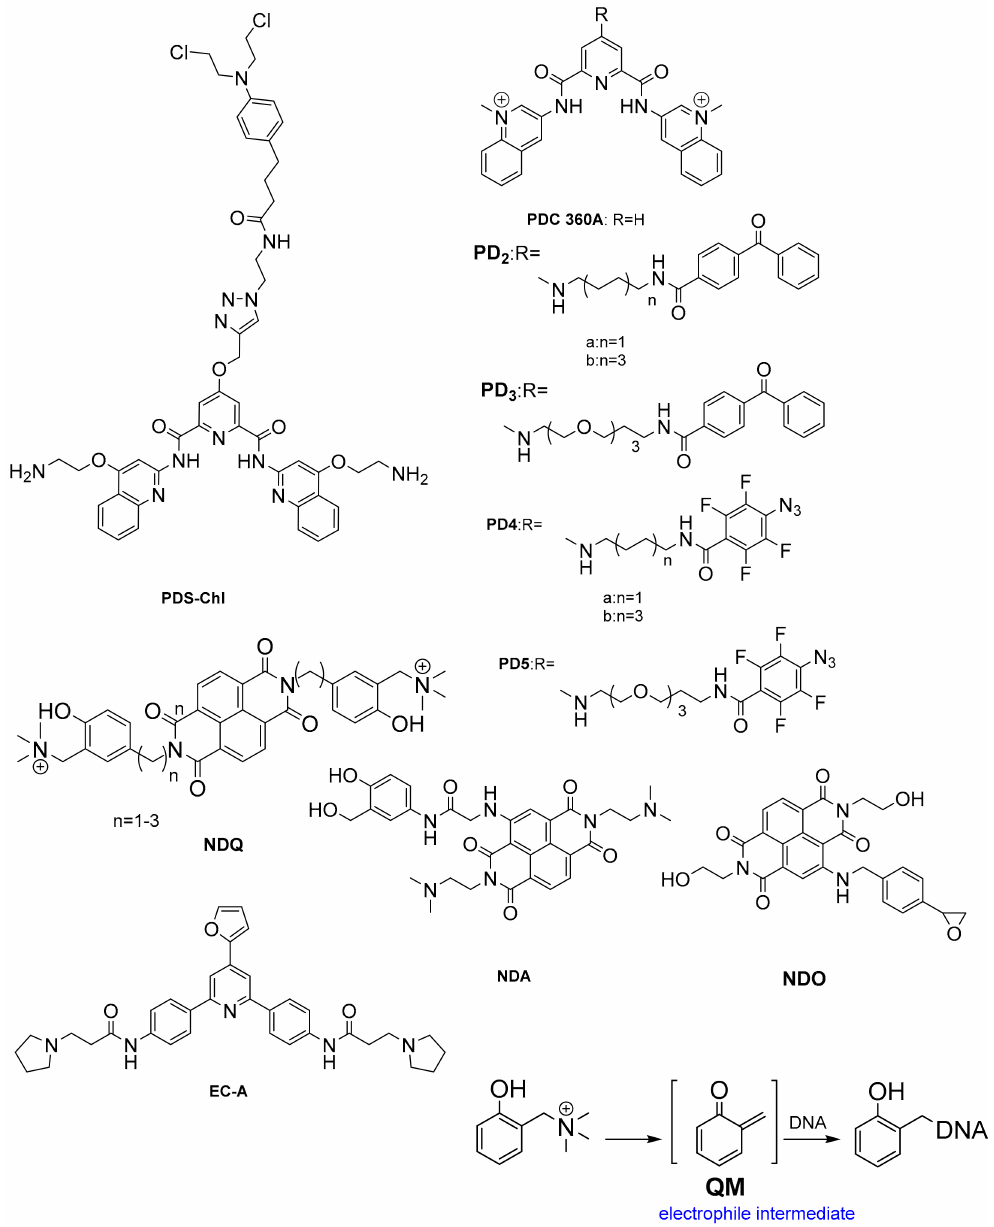
Figure 23. Alkylating G4 ligands and general mechanism of DNA alkylation by in situ generation of quinone